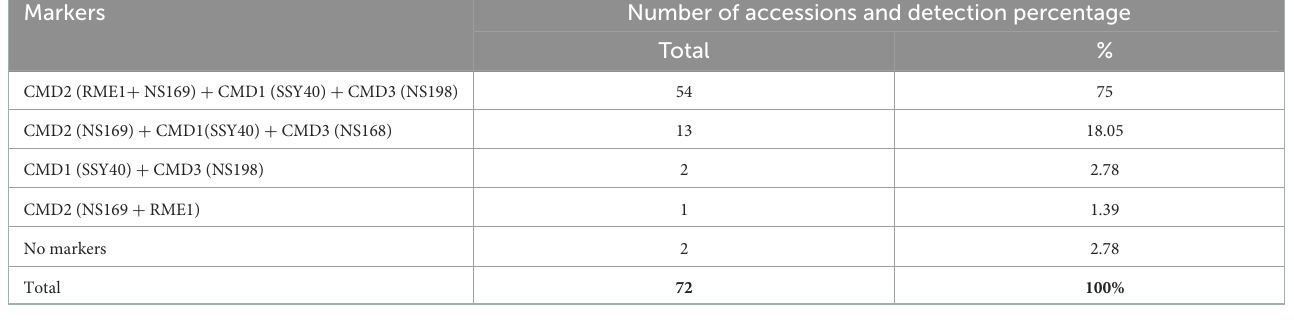
TABLE 4 Combinations of CMD resistance markers found in 72 CMD symptomless cassava accessions in Côte d’Ivoire. Markers Number of accessions and detection percentage